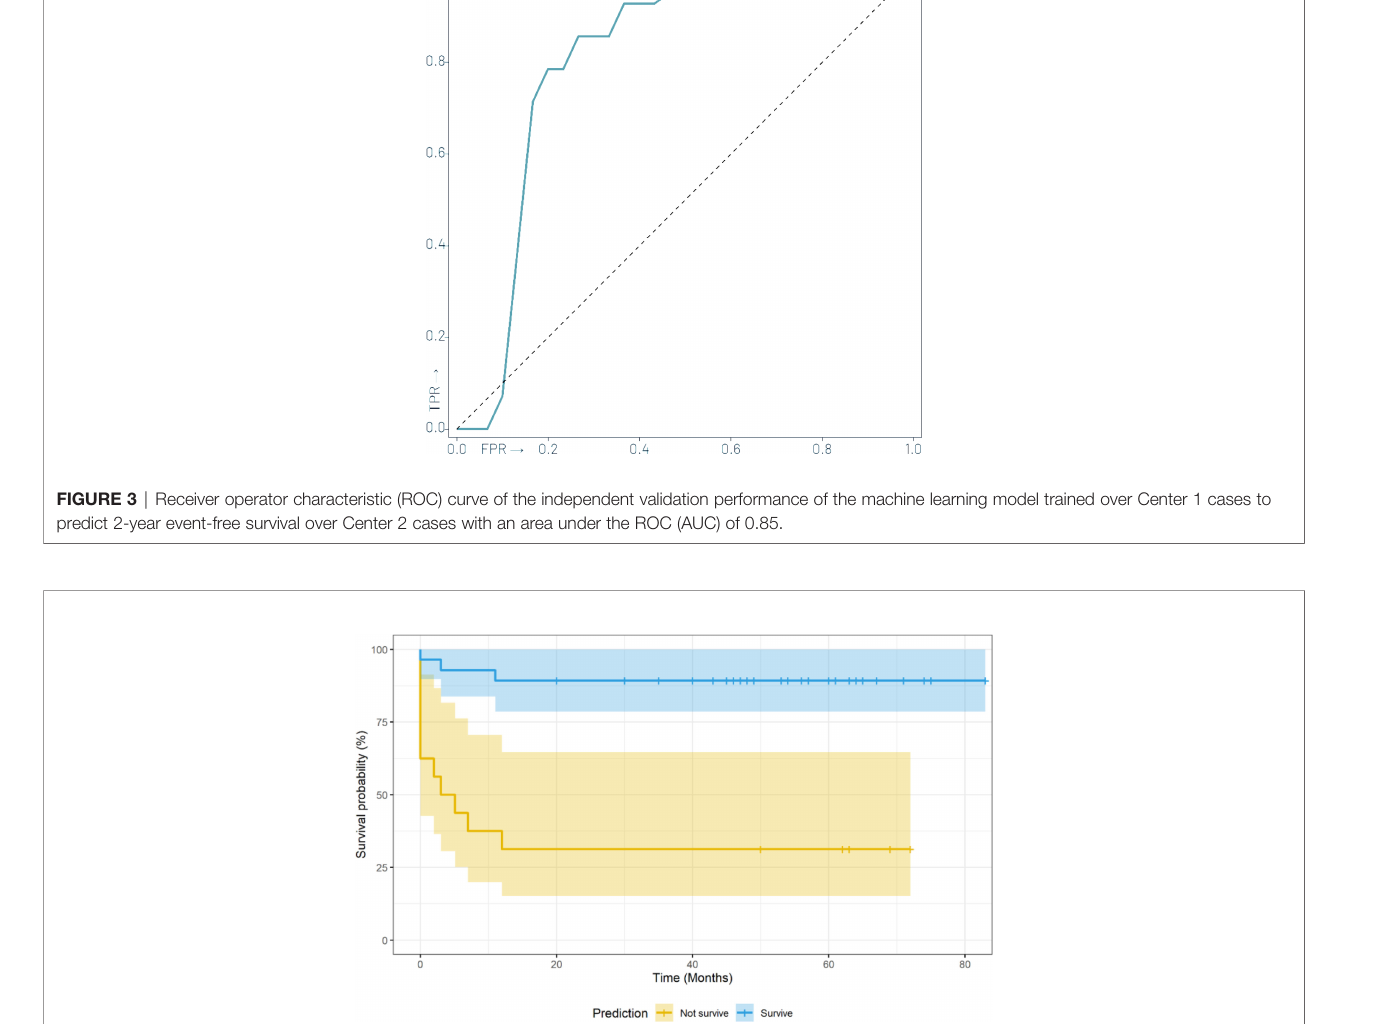
FIGURE 4 | Kaplan – Meier curve of the machine learning (ML) model prediction vs. 2-year event-free survival in Center 2 cases. The ML model was trained with Center 1 cases.